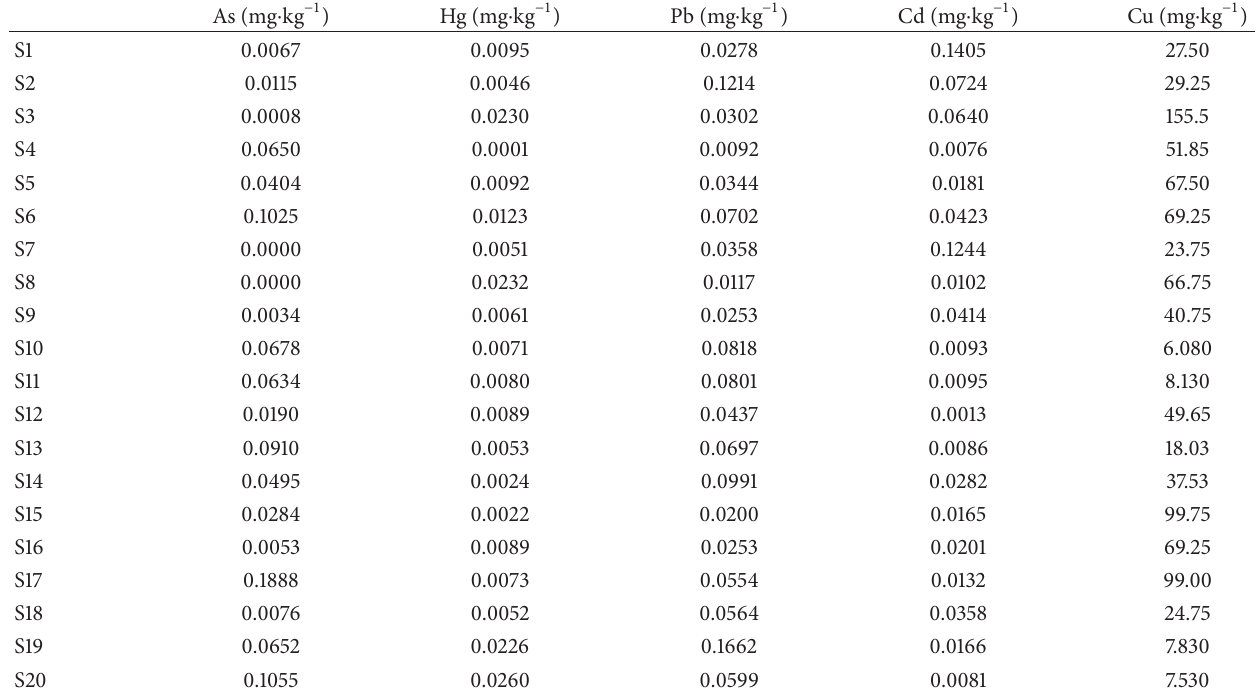
Table 6: The contents of As, Hg, Pb, Cd, and Cu of the investigated